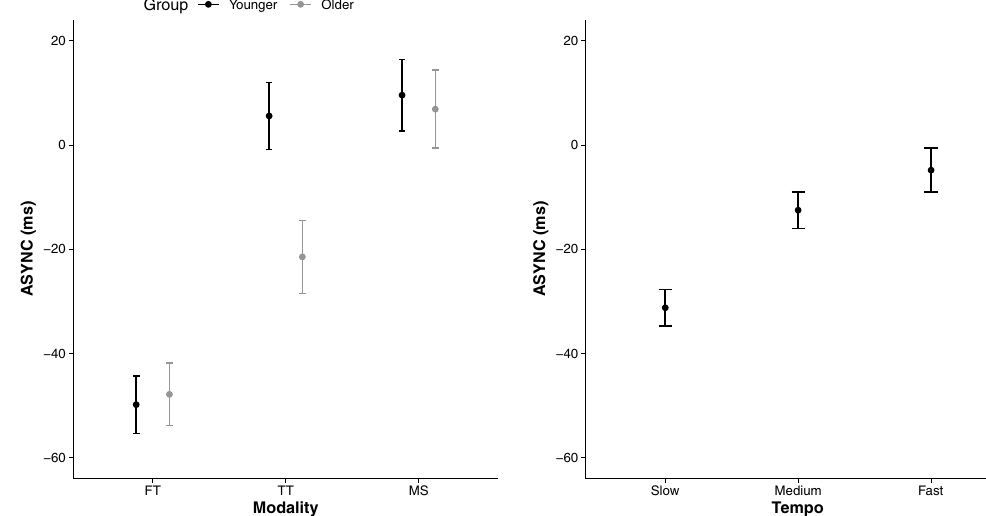
Figure 7. Signed synchronization of self-initiated actions to external predictable events. Mean ASYNC in ms for each Modality (Finger Tapping [FT], Toe Tapping [TT], Marching on the Sport [MS]) as a function of the group (younger, older) in the left panel, and tempo (slow, medium, fast) in the right panel. 95% CIs are represented in the figure by the error bars attached to each mean point.